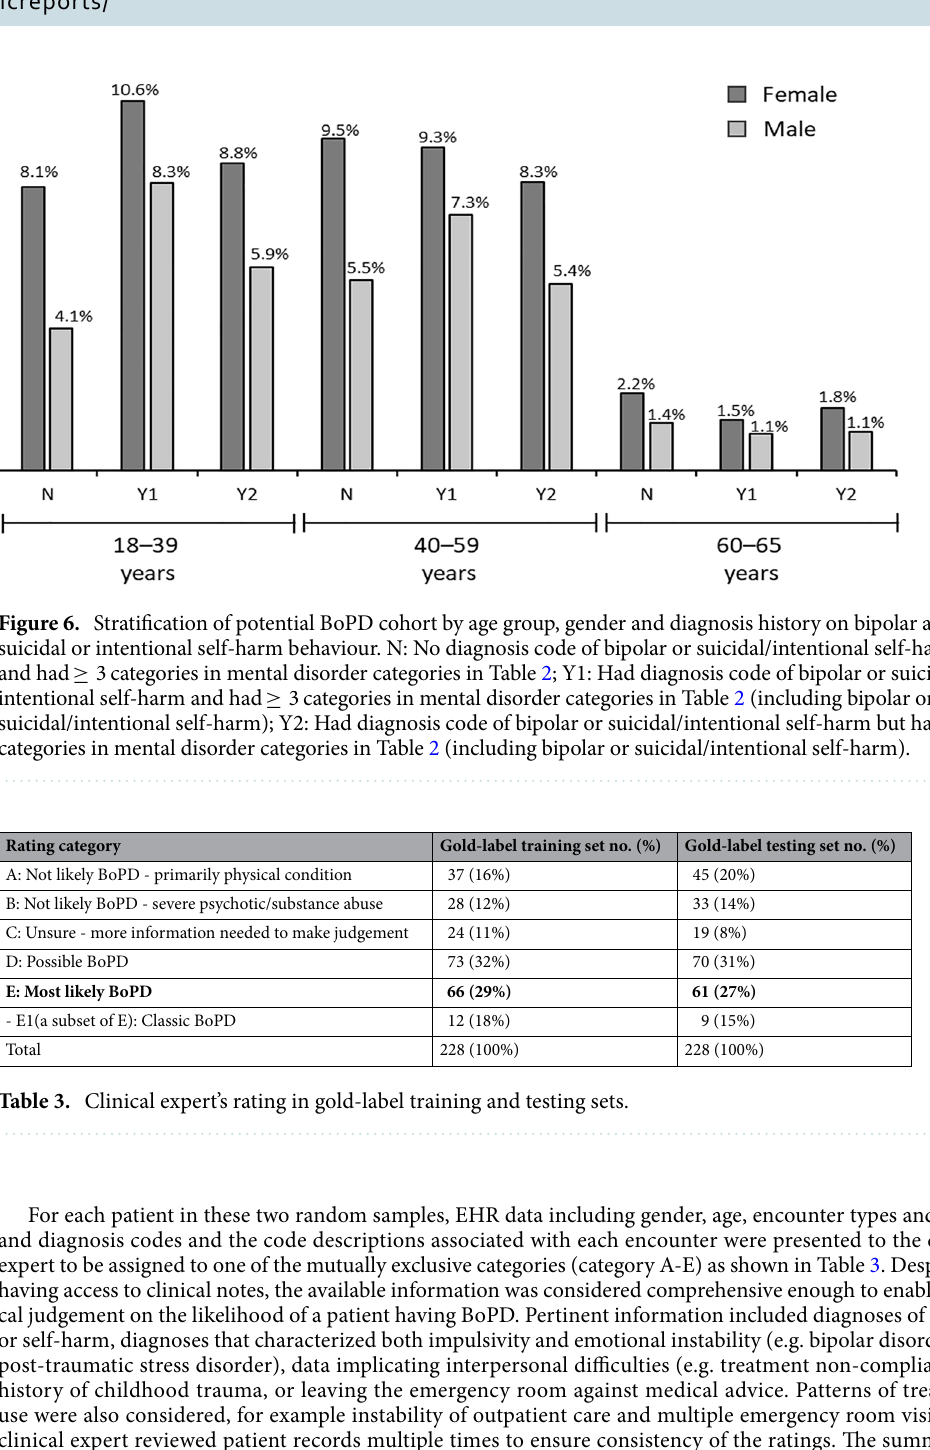
Table 3. Clinical expert’s rating in gold-label training and testing sets.